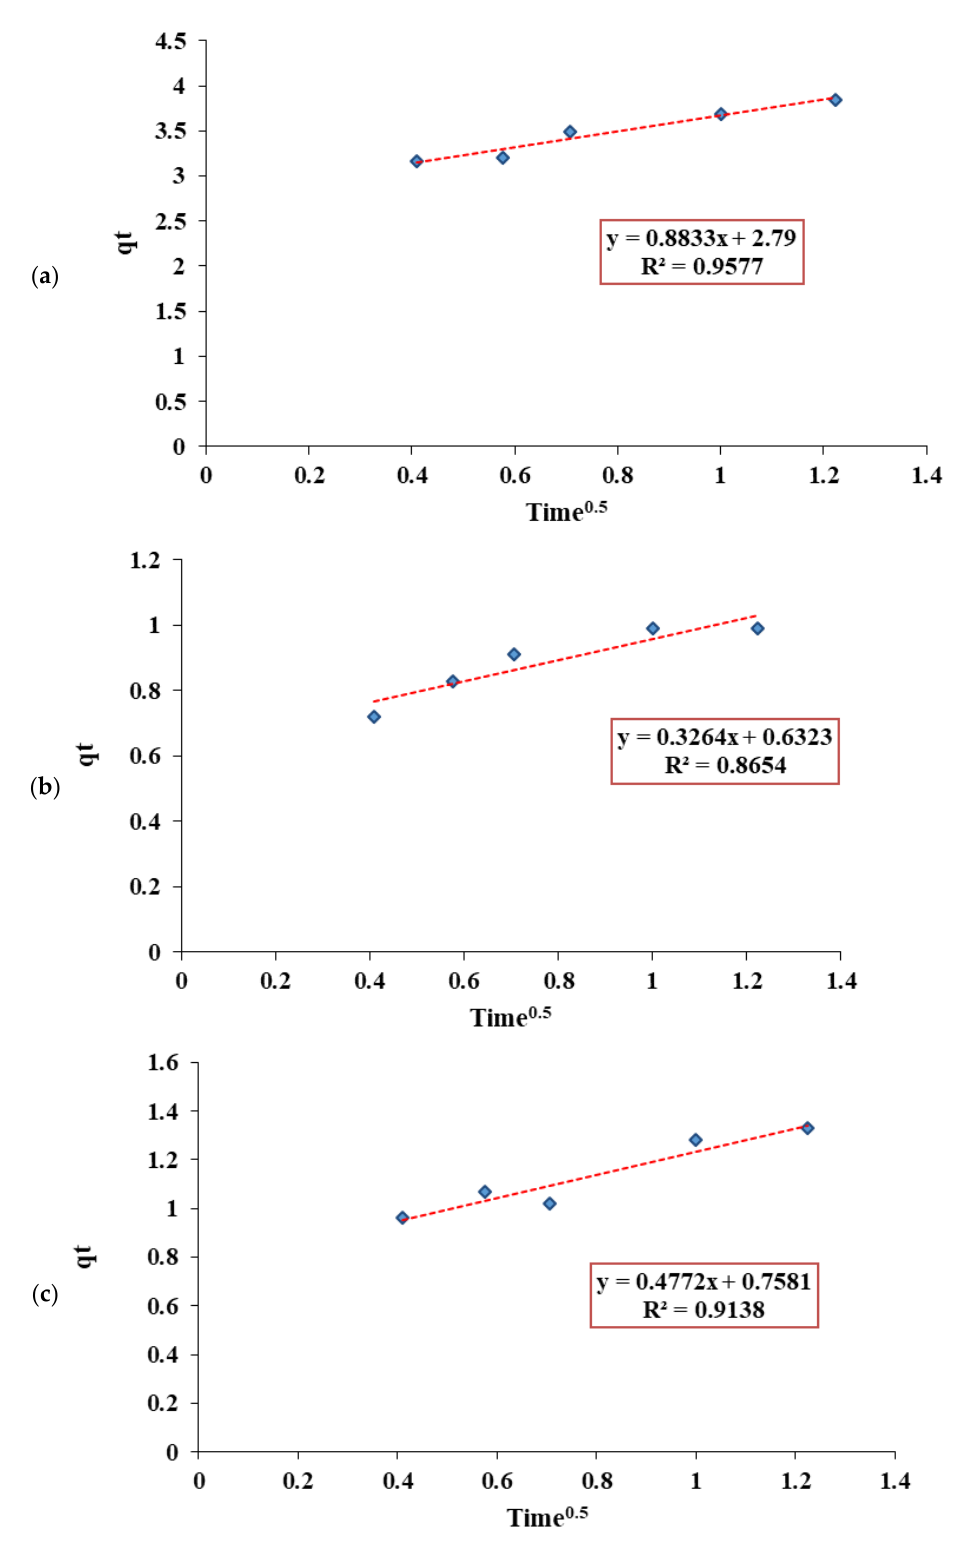
Figure 20. Morris–Weber kinetic model plot of calcium ion adsorption by ( a ) zeolite, ( b ) activated carbon, and ( c ) activated alumina.